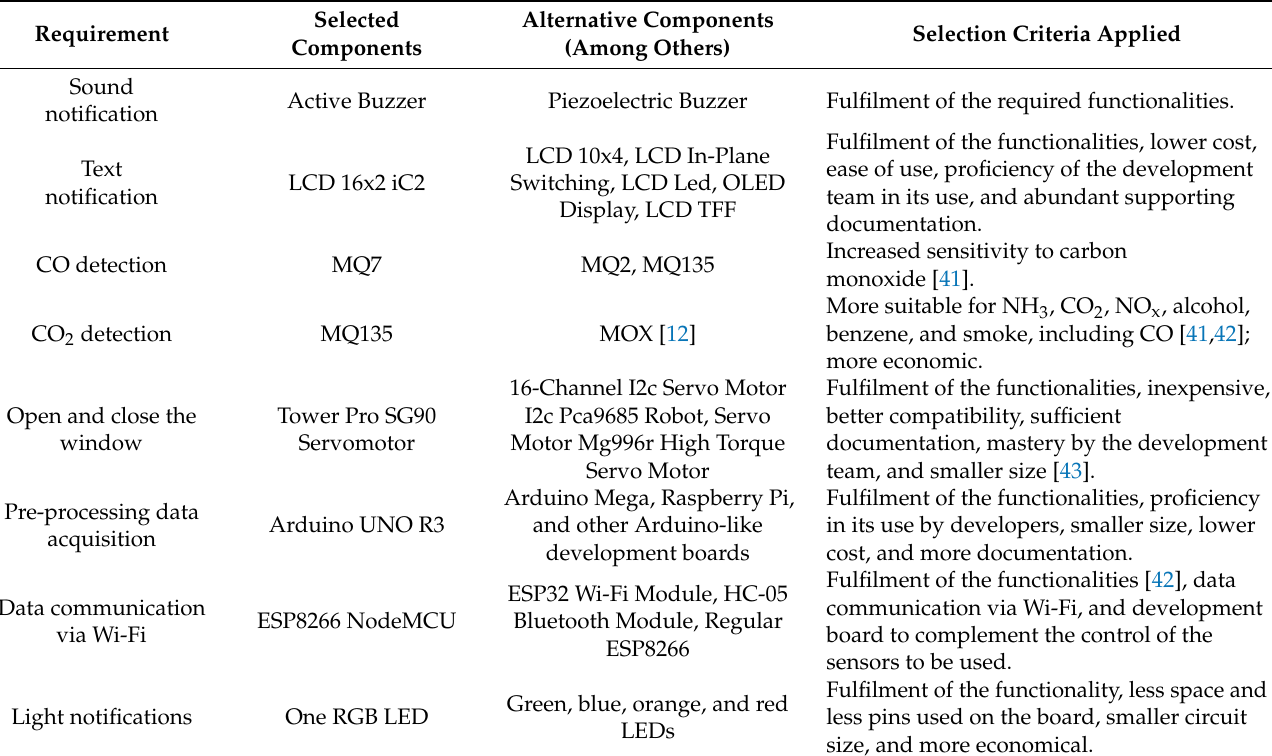
Table 3. Hardware components selected to be used in the